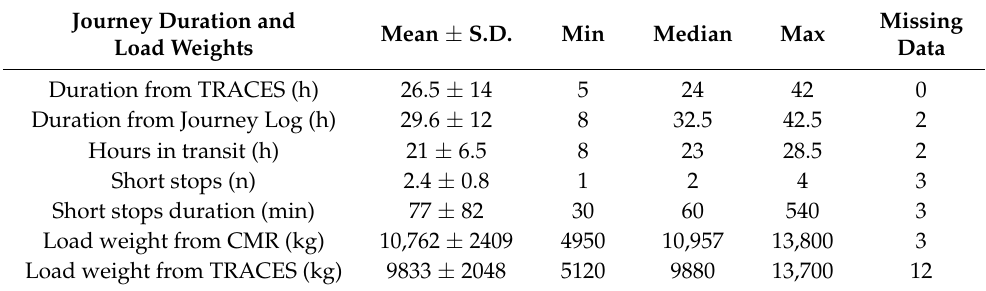
Table 5. Descriptive statistics for the journey durations and load weight observed from the documen- tation of the 32 journeys of handled horses towards the two Italian slaughterhouses. Journey Duration and Mean ± S.D. Min Median Max Load Weights